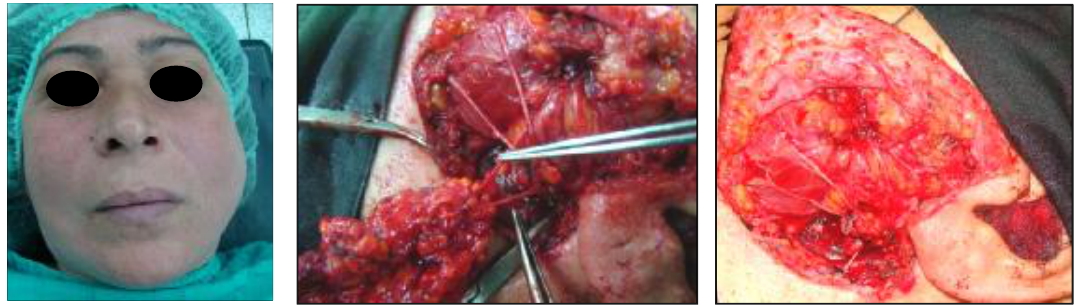
Figure 4: Patient with left parotid encapsulated mass involving buccal branch of facial nerve which was preserved.